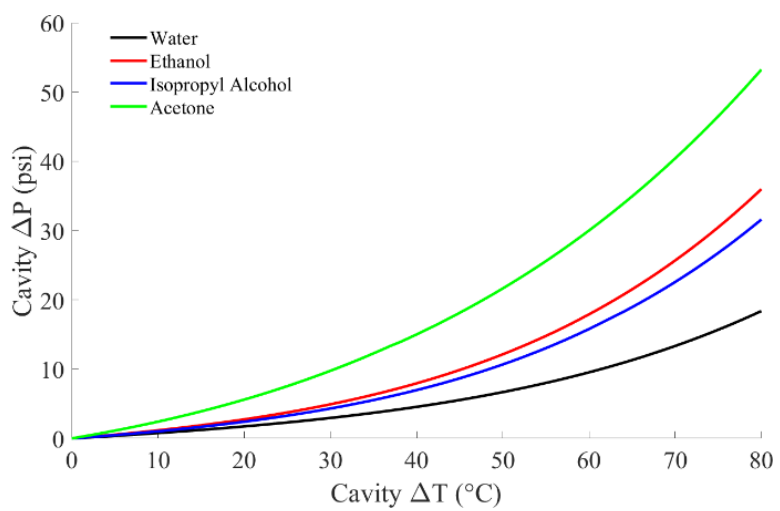
Figure 9. Theoretical pressure change vs. temperature change for multiple different liquids.